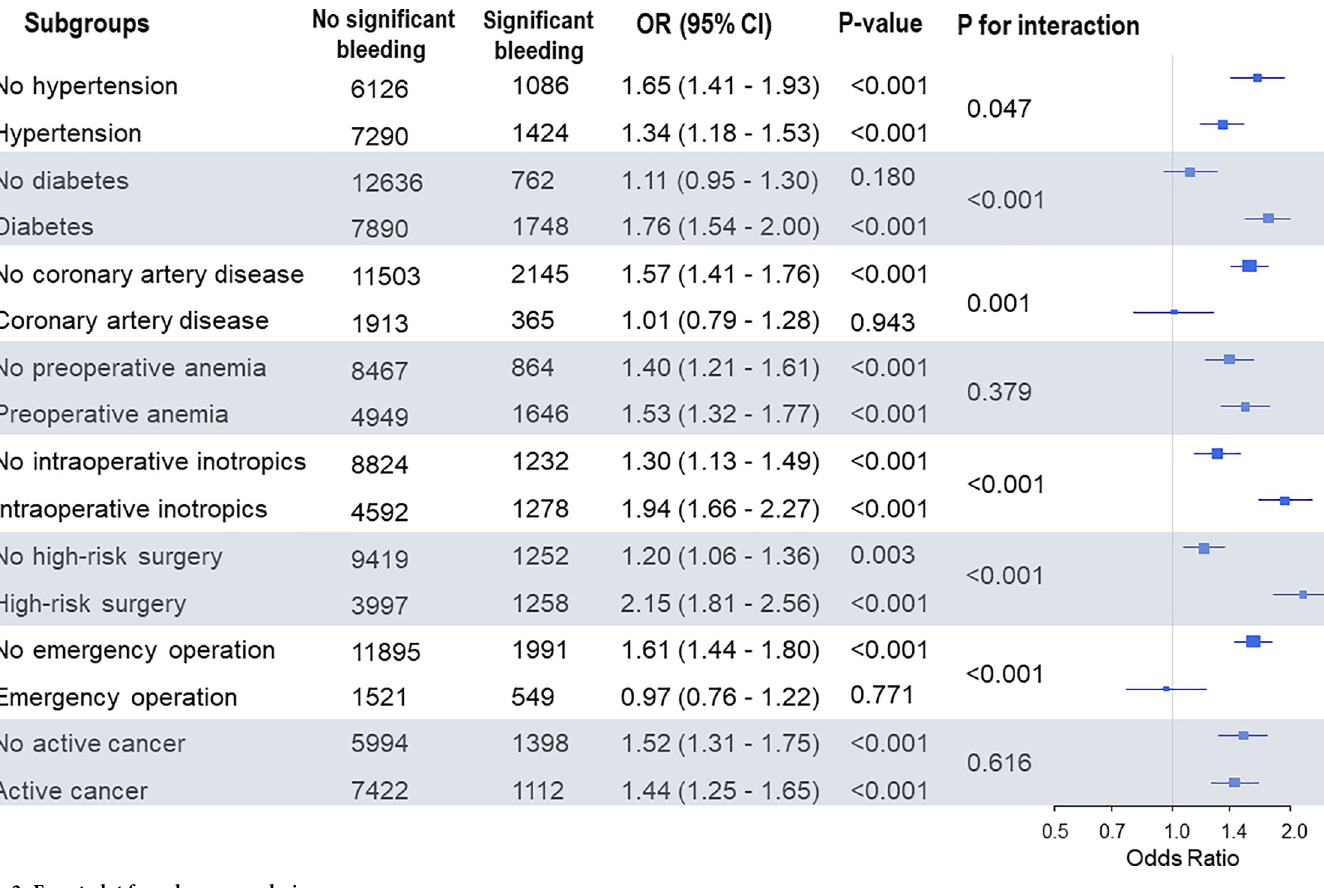
p < 0.001 for no hemoglobin decrease with transfusion; OR, 6.13; 95% CI, 4.81–7.82; p < 0.001 for hemoglobin decrease without transfusion; and OR, 8.66; 95% CI, 6.77–10.96; p < 0.001 for hemoglobin decrease with transfusion) (Table 3). When the patients were solely